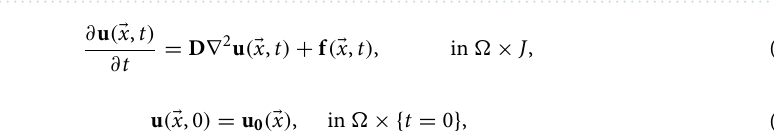
Figure 5. ( a ) Contour solution plot of 2D heat conduction or diffusion problem at time T x-y square grid (qubit-layer m x - m y - l (